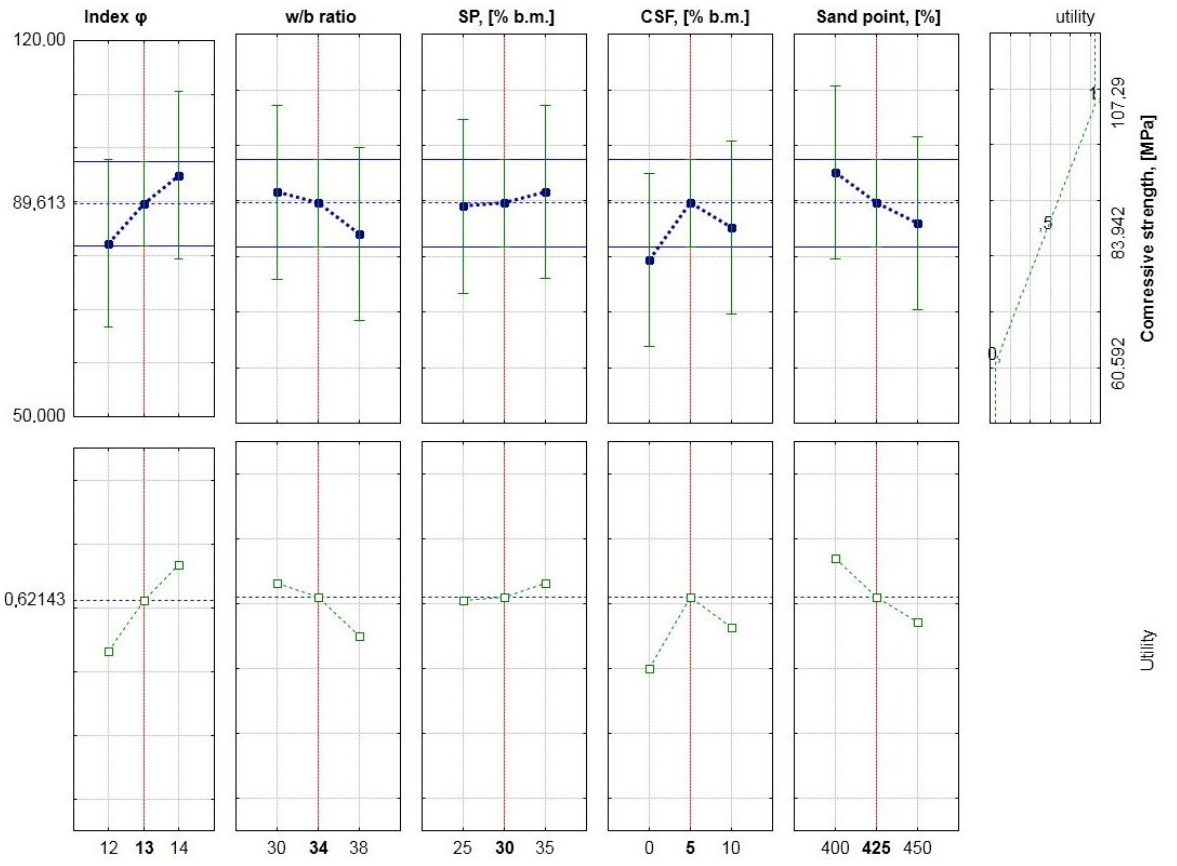
Figure 5. Value profiles of approximated compressive strengths for HPSCC.